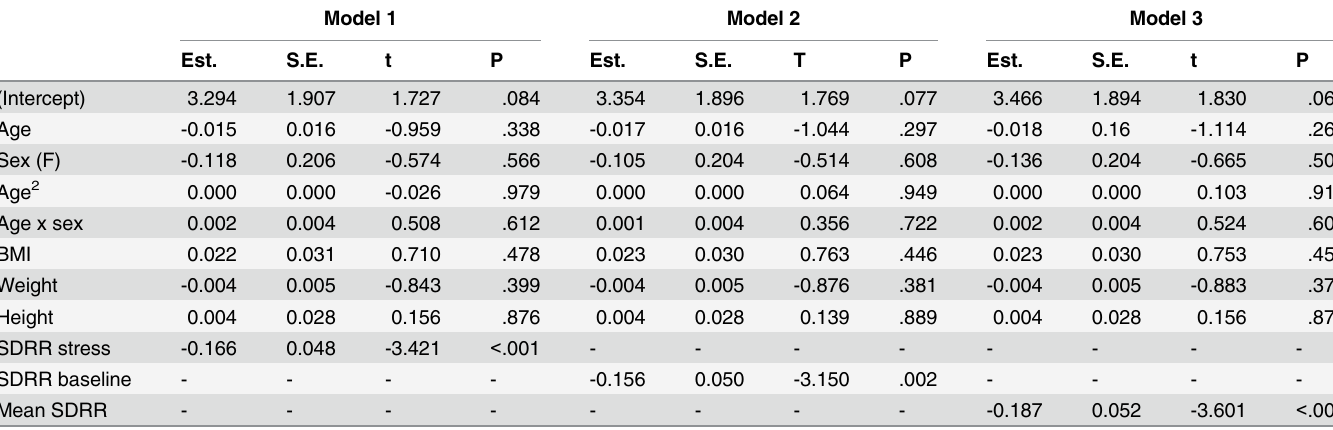
Table 2. Relationships between SDRR measure of HRV and